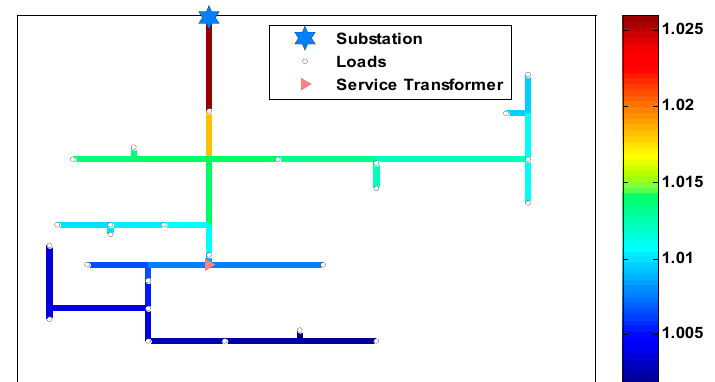
Figure 11. Voltage profile of all buses in the IEEE 37 bus distribution system.